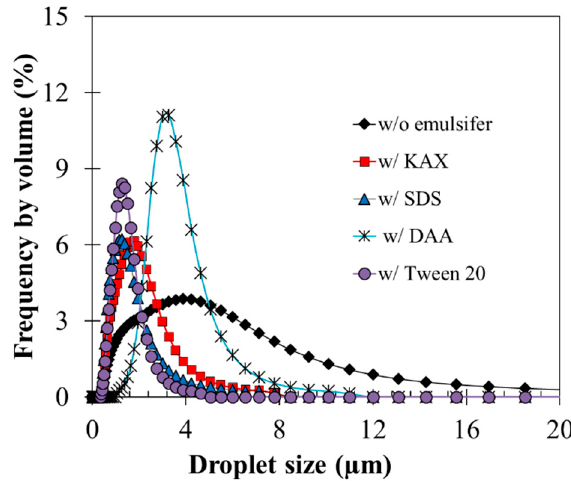
Figure 4. Size distribution of oil droplets after emulsification with and without addition of emulsifiers.